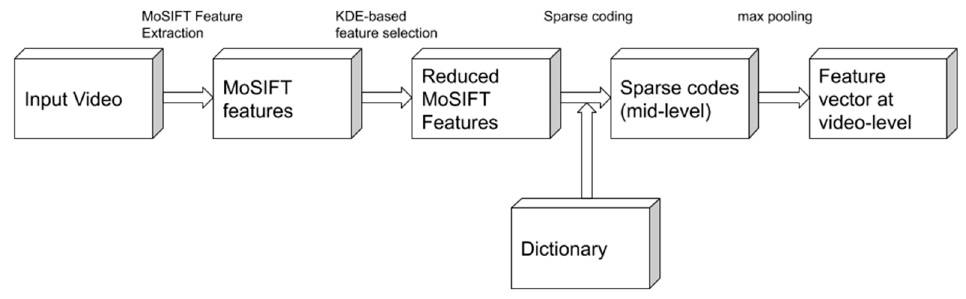
Figure 5. Steps of the approach used in [13].